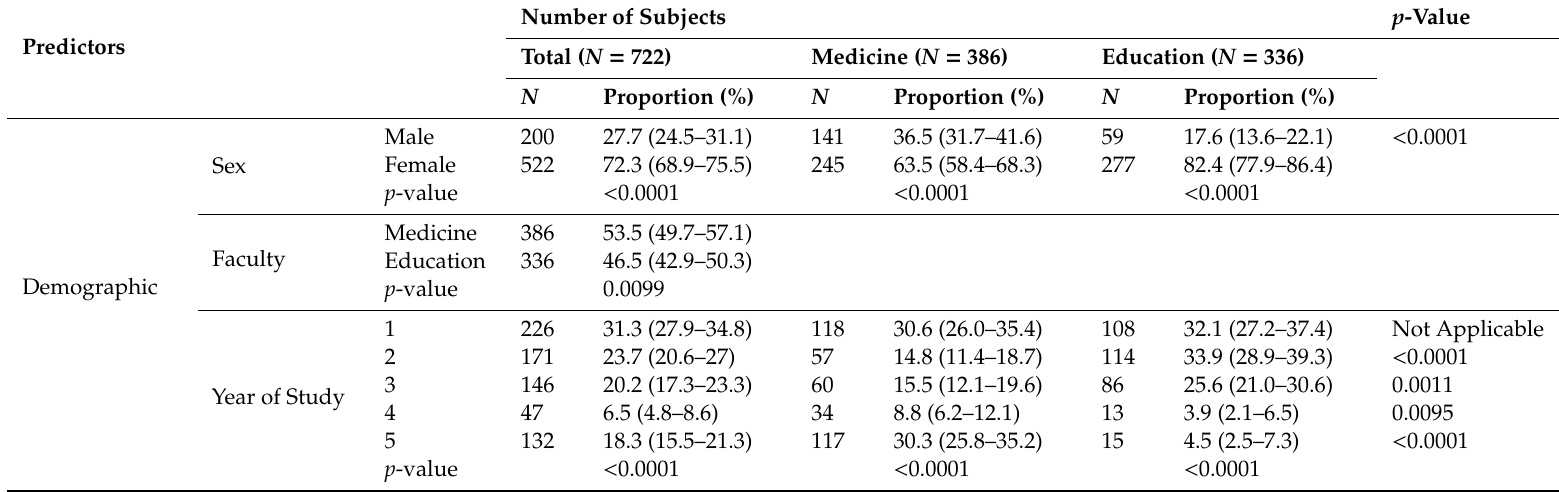
Table 1. Descriptive analysis of